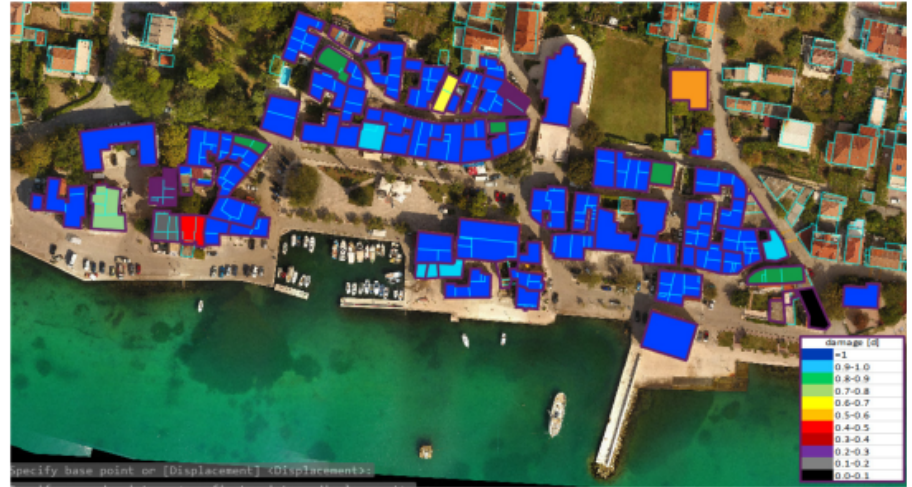
Figure 19. Map of the damage index for PGA = 0.11 g and a return period T = 95